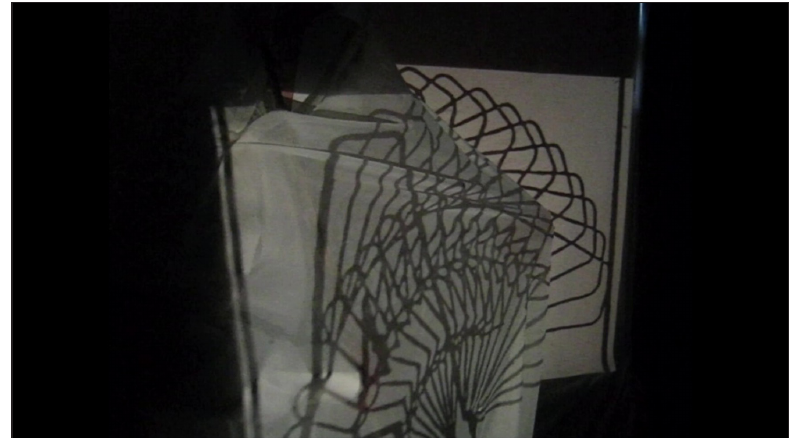
Figure 4.4: (7.34) Jennifer Pike with Veryan Weston, 2007. Courtesy of Veryan